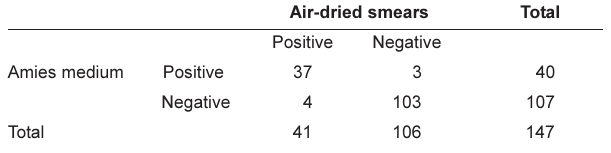
TABLE 2 Comparison of diagnoses of bacterial vaginosis from slides prepared from swabs in Amies medium and from standard air-dried smears